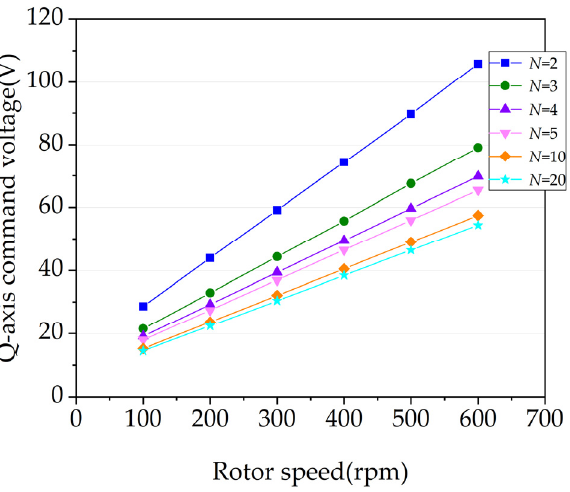
Figure 6. Measured q -axis command voltage with respect to rotor speed ( i d = 0, i q = 3 A).